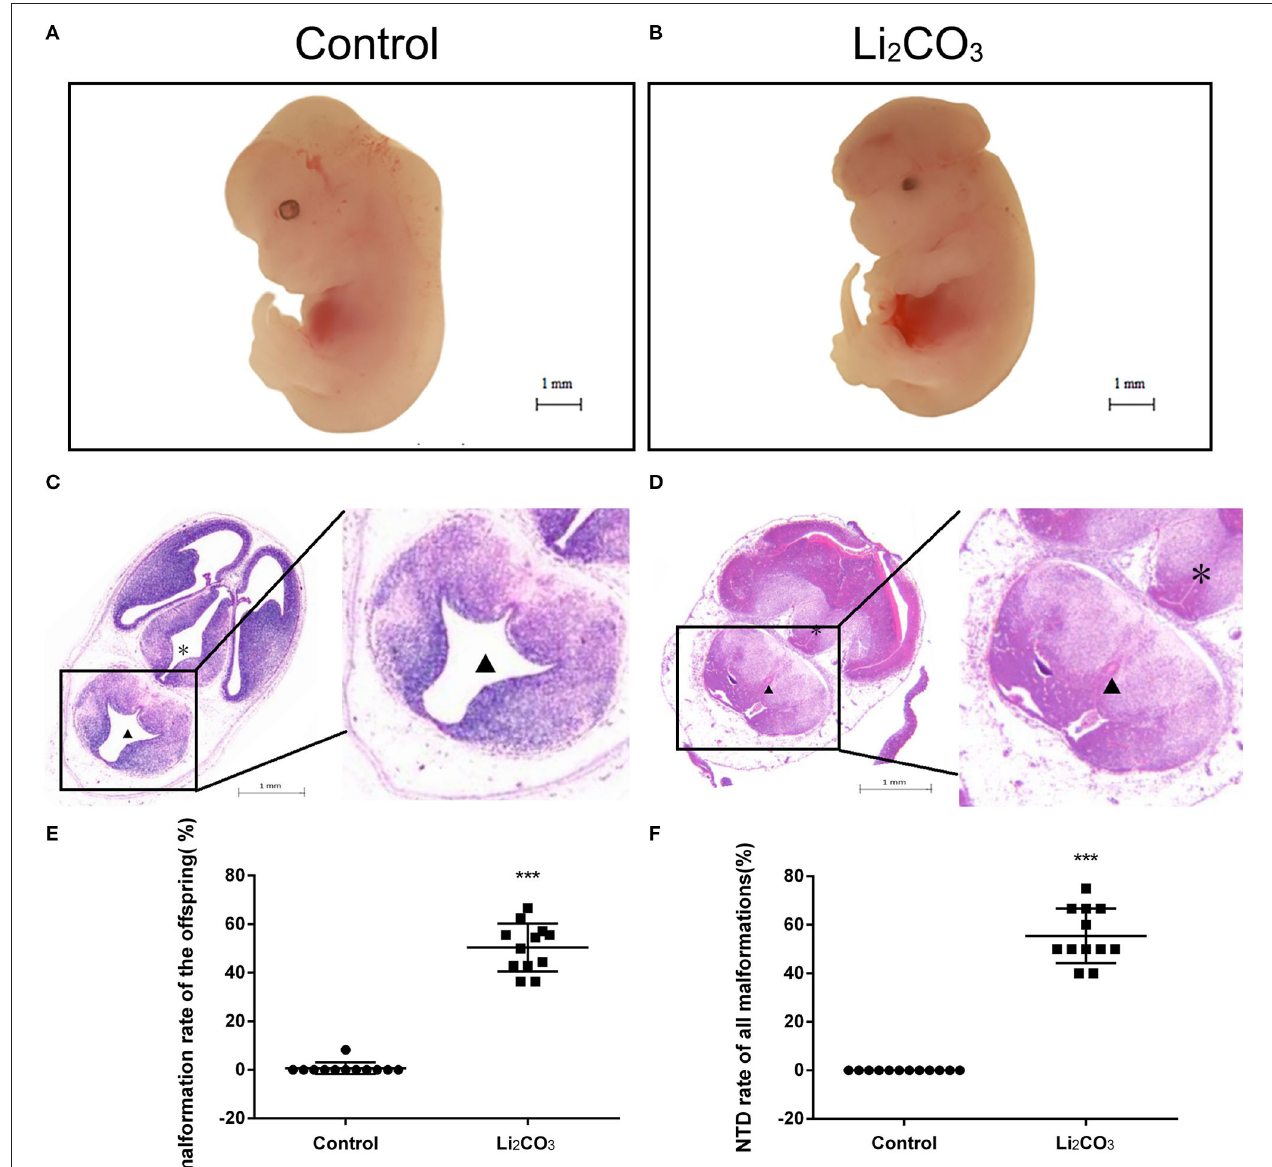
FIGURE 1 | Morphological changes in the NTDs mouse model at E 13.5. (A) Control embryos viewed under the dissecting microscope. (B) NTDs mouse model embryos viewed under the dissecting microscope. (C) Photomicrograph of the light microscopy of the hematoxylin and eosin (H&E)-stained section of mouse embryo brain tissue in the control group ( n = 6). (D) Photomicrograph of the light microscopy of the H&E-stained section of mouse model embryos in the NTDs group ( n = 6). (E) Malformation rate of the offspring in C57BL/6 mice with or without Li 2 CO 3 . Incidence rates were calculated by embryos. (F) NTDs rate of all malformations in C57BL/6 mice with or without Li 2 CO 3 . The statistical differences of malformation rate and NTDs rate of all malformations per litter between the control group ( n = 12) and the NTDs group ( n = 12) were compared by student’s t -test. *** P < 0.001 vs. control group. Slice site: *Third ventricle, N Fourth